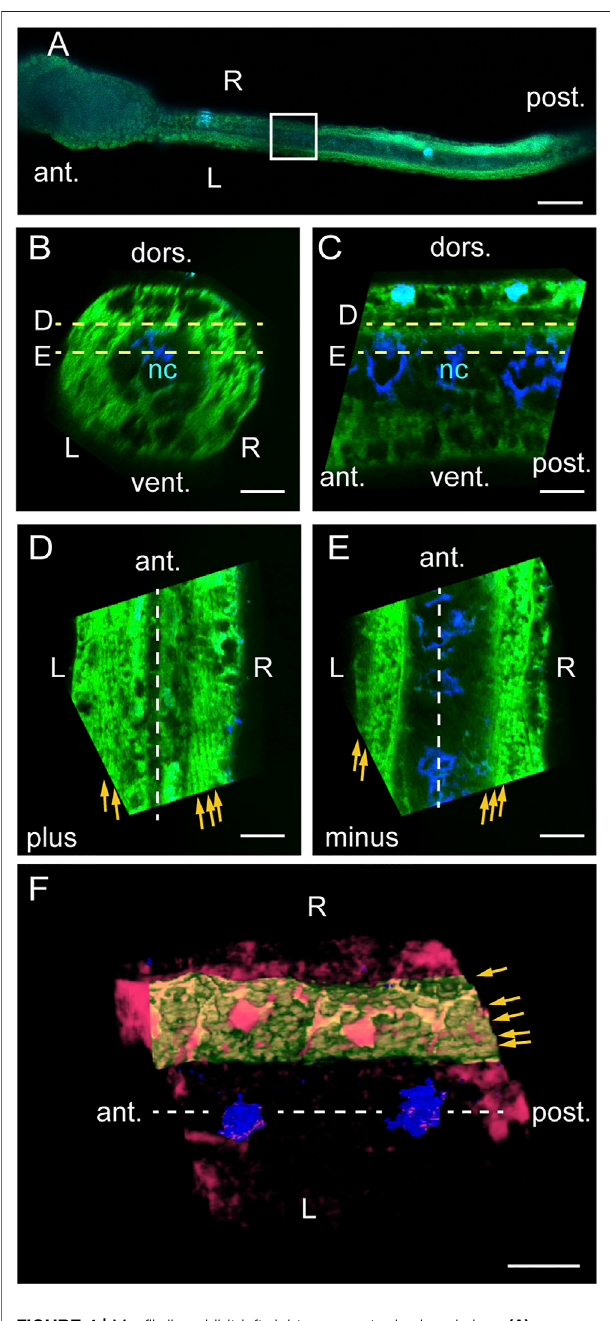
FIGURE 4 | Myo fi brils exhibit left-right asymmetry in dorsal view. (A) Dorsal view of a phalloidin/DAPI-stained Ciona larva at 24 hpf. Boxed photo- bleached area is analyzed in (B – F) . Scale bar, 50 μ m. (B) Posterior view of a cross-section in silico. Scale bar, 10 μ m. (C) Left view of a midsagittal section in silico. Scale bar, 10 μ m. (D) Dorsal view of a horizontal section insilicothroughthetopofdorsalmusclecellsatlevelDin (B,C) .Yellowarrows indicate fi ne lines detected. Scale bar, 10 μ m. (E) Horizontal section through the bottom of dorsal muscle cells at level E in (B, C) . Scale bar, 10 μ m. (F) Dorsal view of 3D-rendered muscle cells. Red, high intensity phalloidin signals above a certain threshold. Green, a left dorsal muscle cell segmented in silico. Blue, DAPI. Scale bar, 10 μ m. The midsagittal plane is indicated by dashed lines. Brightness was adjusted in the left and right halves of the image separately in (D, E)